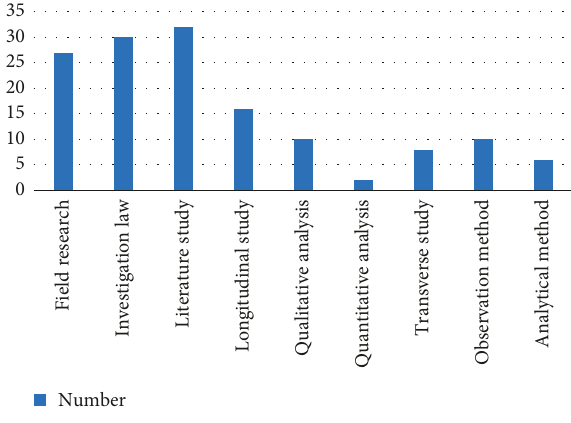
Figure 3: Summary of research